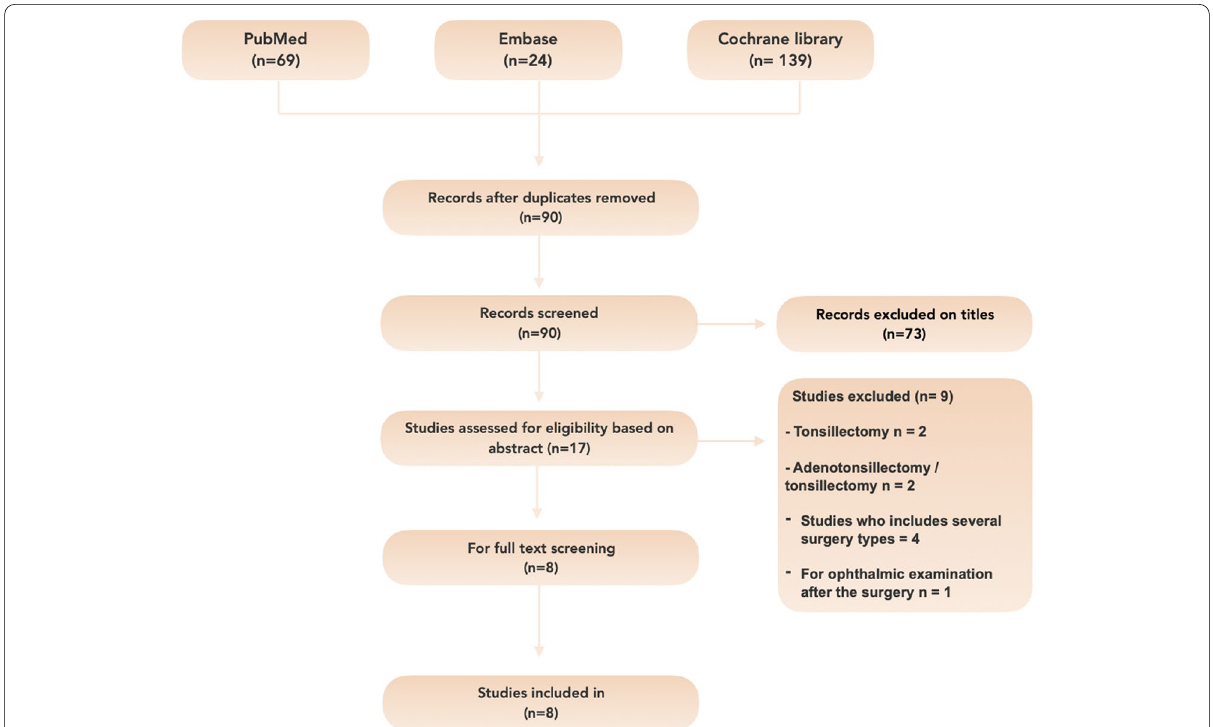
Fig. 1 Modified PRISMA flowchart illustrating the systematic search and selection